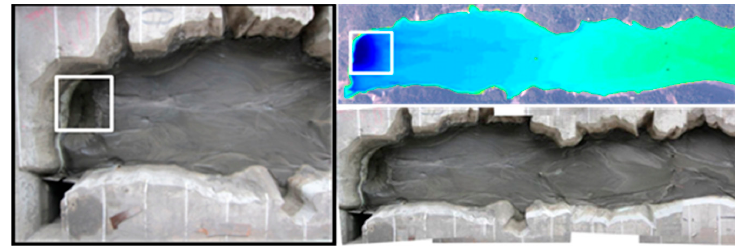
Figure 8. Ultimate depositional pattern of the Wushe Reservoir.